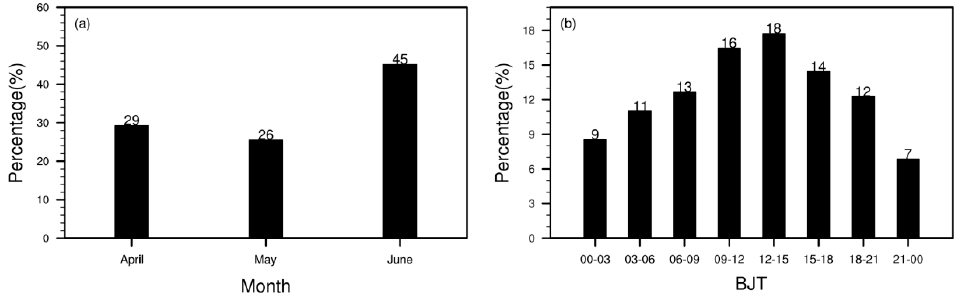
Figure 3. ( a ) Monthly and ( b ) diurnal variations of the MVs in Guangdong from April to June during 2017–2019.